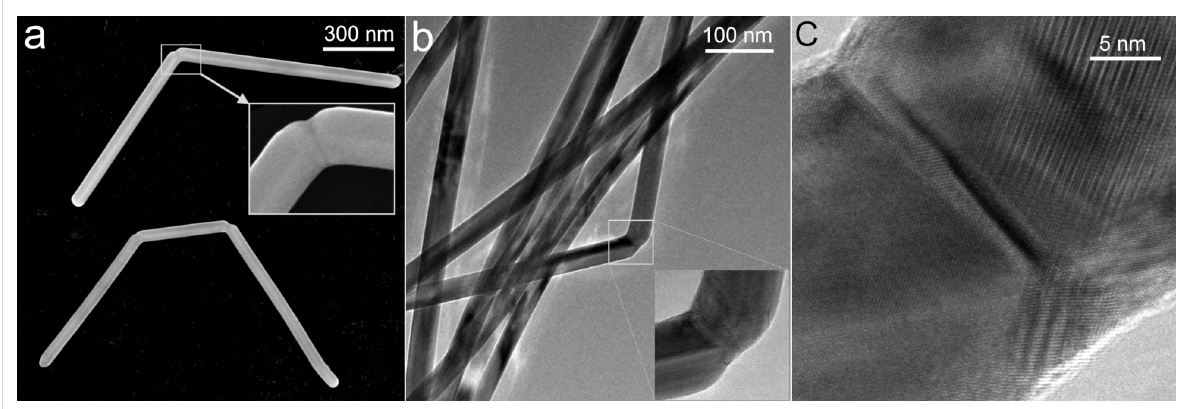
Figure 3: SEM (a) and TEM (b,c) images of deformed Ag NWs drop-cast from a